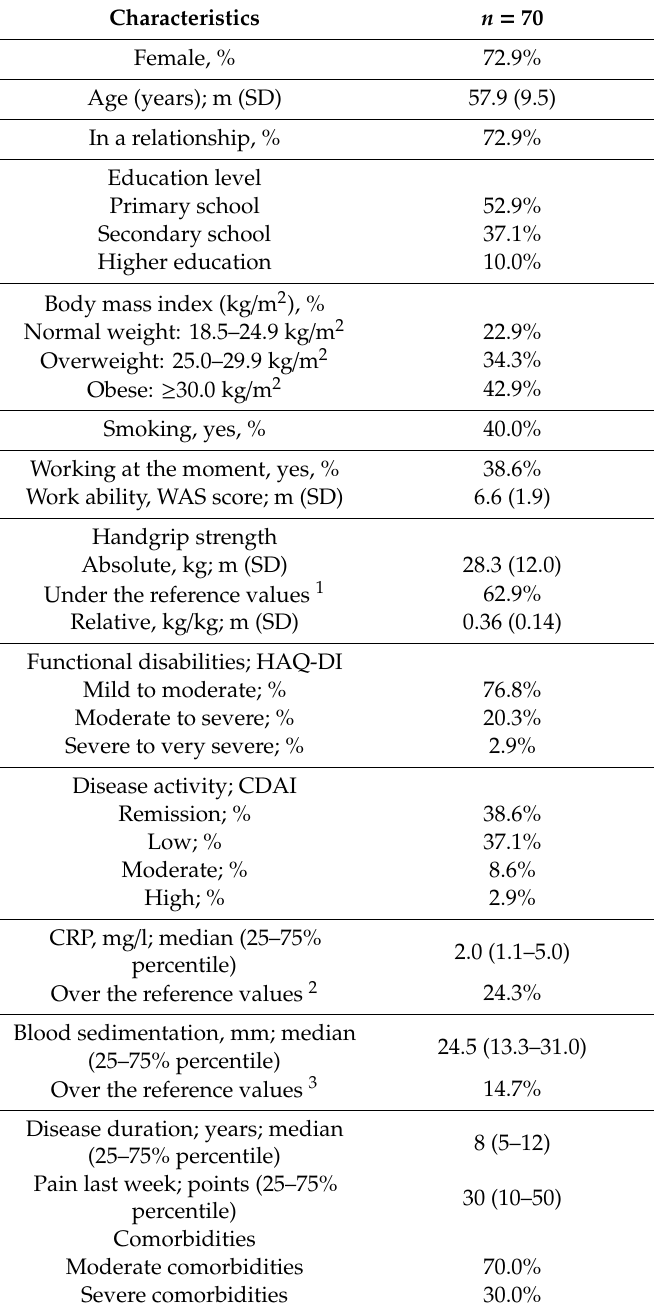
Table 1. Characteristics of the study